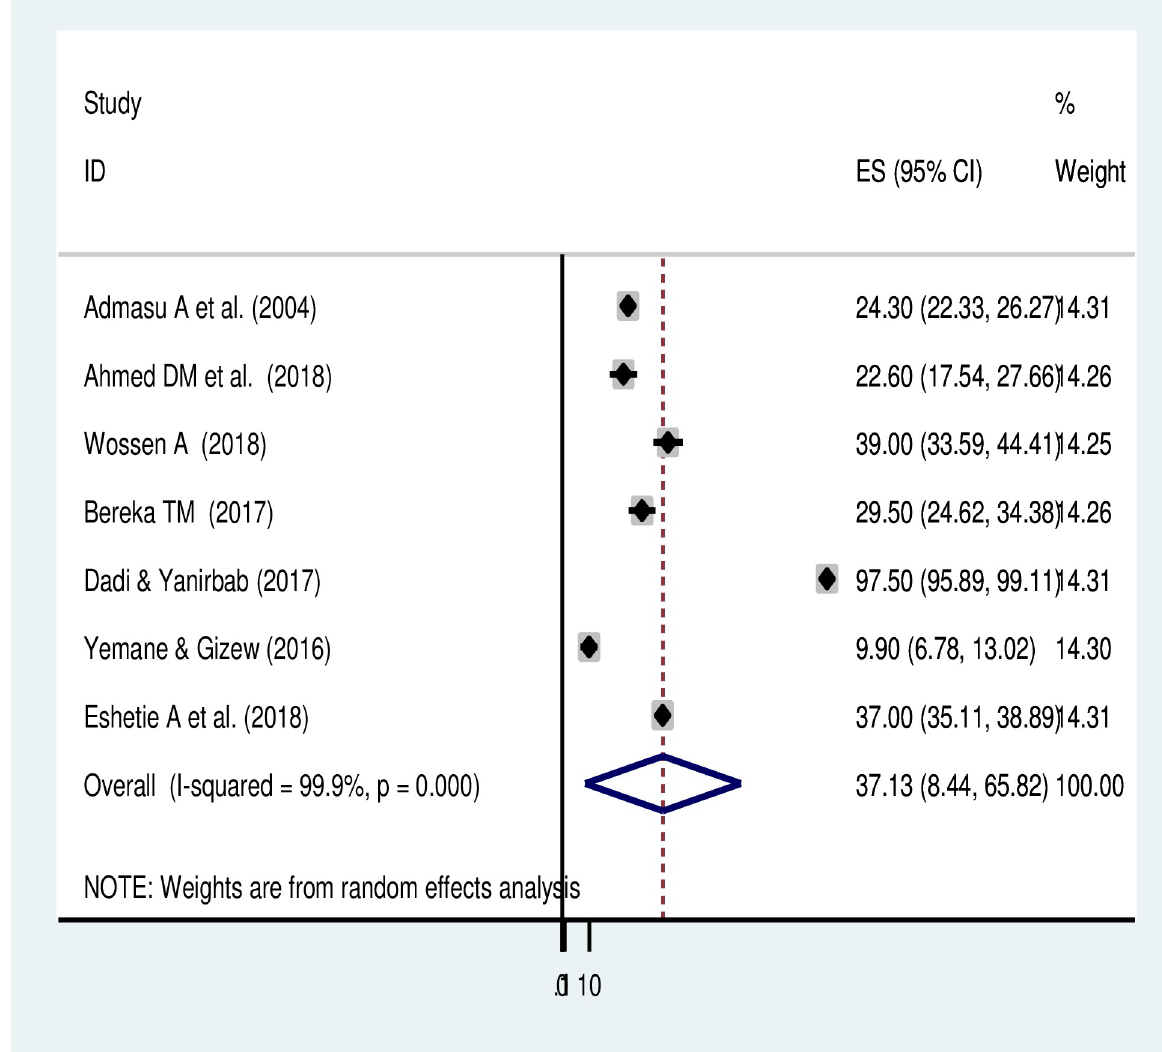
The meta-analysis of 2 studies showed that prolonged duration of operation was a significant predictor of maternal morbidity among women with uterine rupture. Women who had pro- longed duration of operation more than 2 hours had 1.39 times higher odds of maternal mor- bidity (OR:1.39; 95% CI: 1.06, 1.81) (Fig 6).